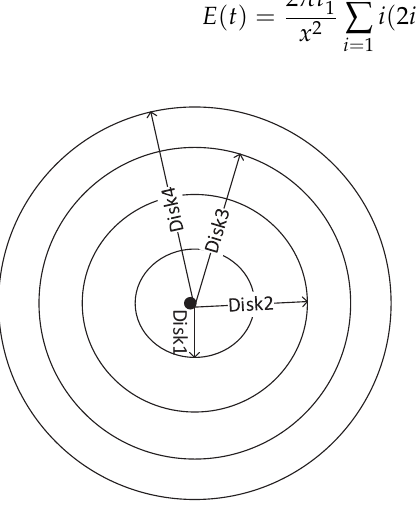
Figure 6. Disk Formation for